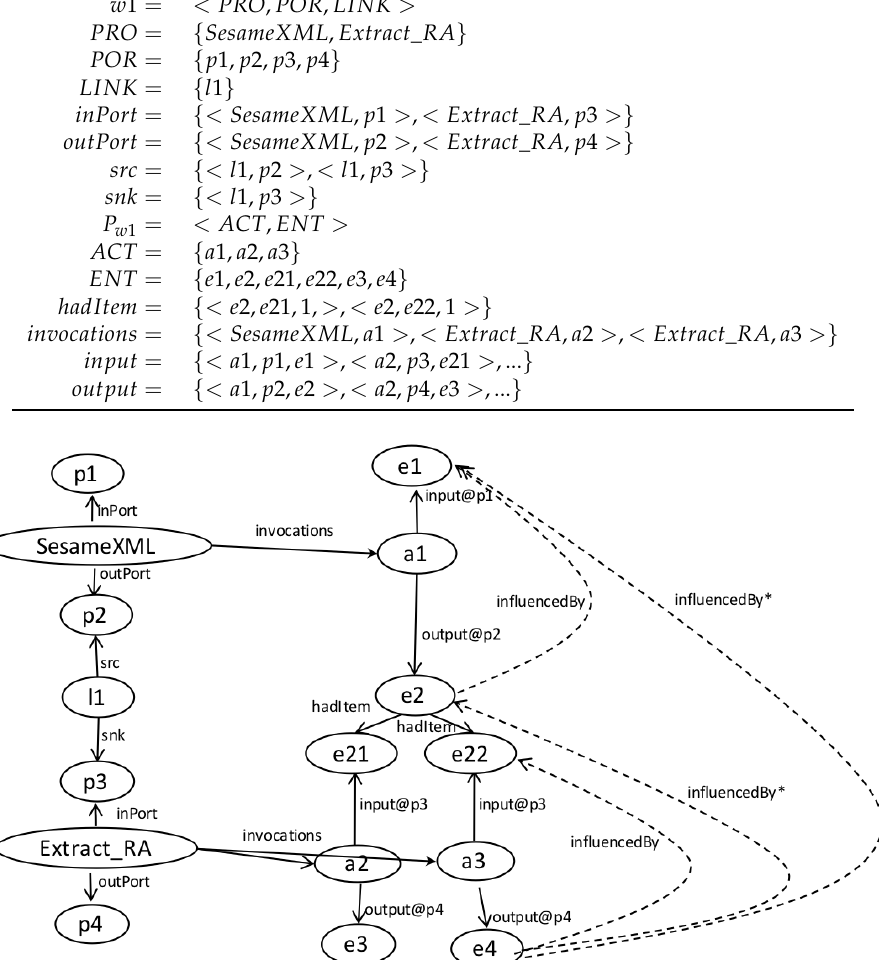
Figure 4. Diagrammatic view w 1 and P w 1